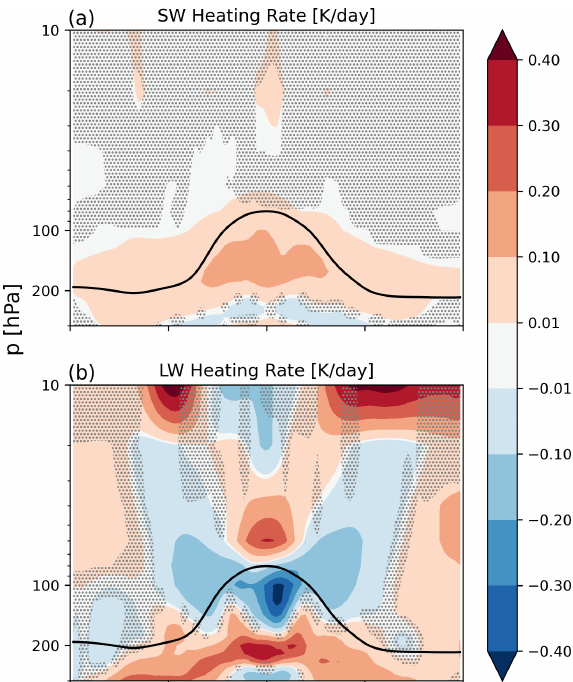
Figure 13. Five-year zonal mean (a) SW and (b) LW heating rate anomalies in Kd − 1 for D19 with a seeding particle concentration of 100INPL − 1 . Anomalies are only shown for the upper troposphere and the stratosphere between 300 and 10hPa. The black line is the 5-year mean zonal mean WMO-defined tropopause height at pres- sure levels. The stippling in the difference plots shows insignificant data points at the 95% confidence level according to the indepen- dent t test controlled by the false discovery rate